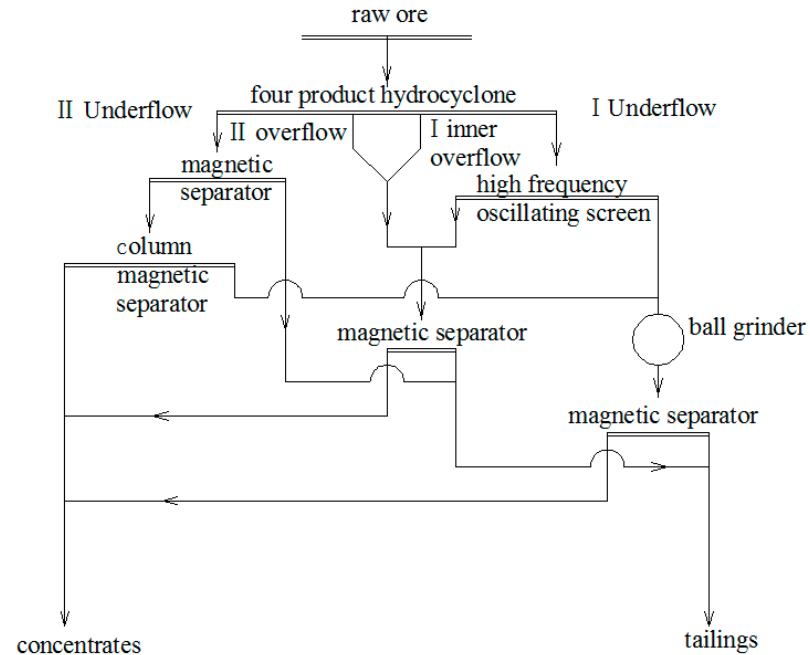
Figure 23. The process flow diagram of four-product cyclone.